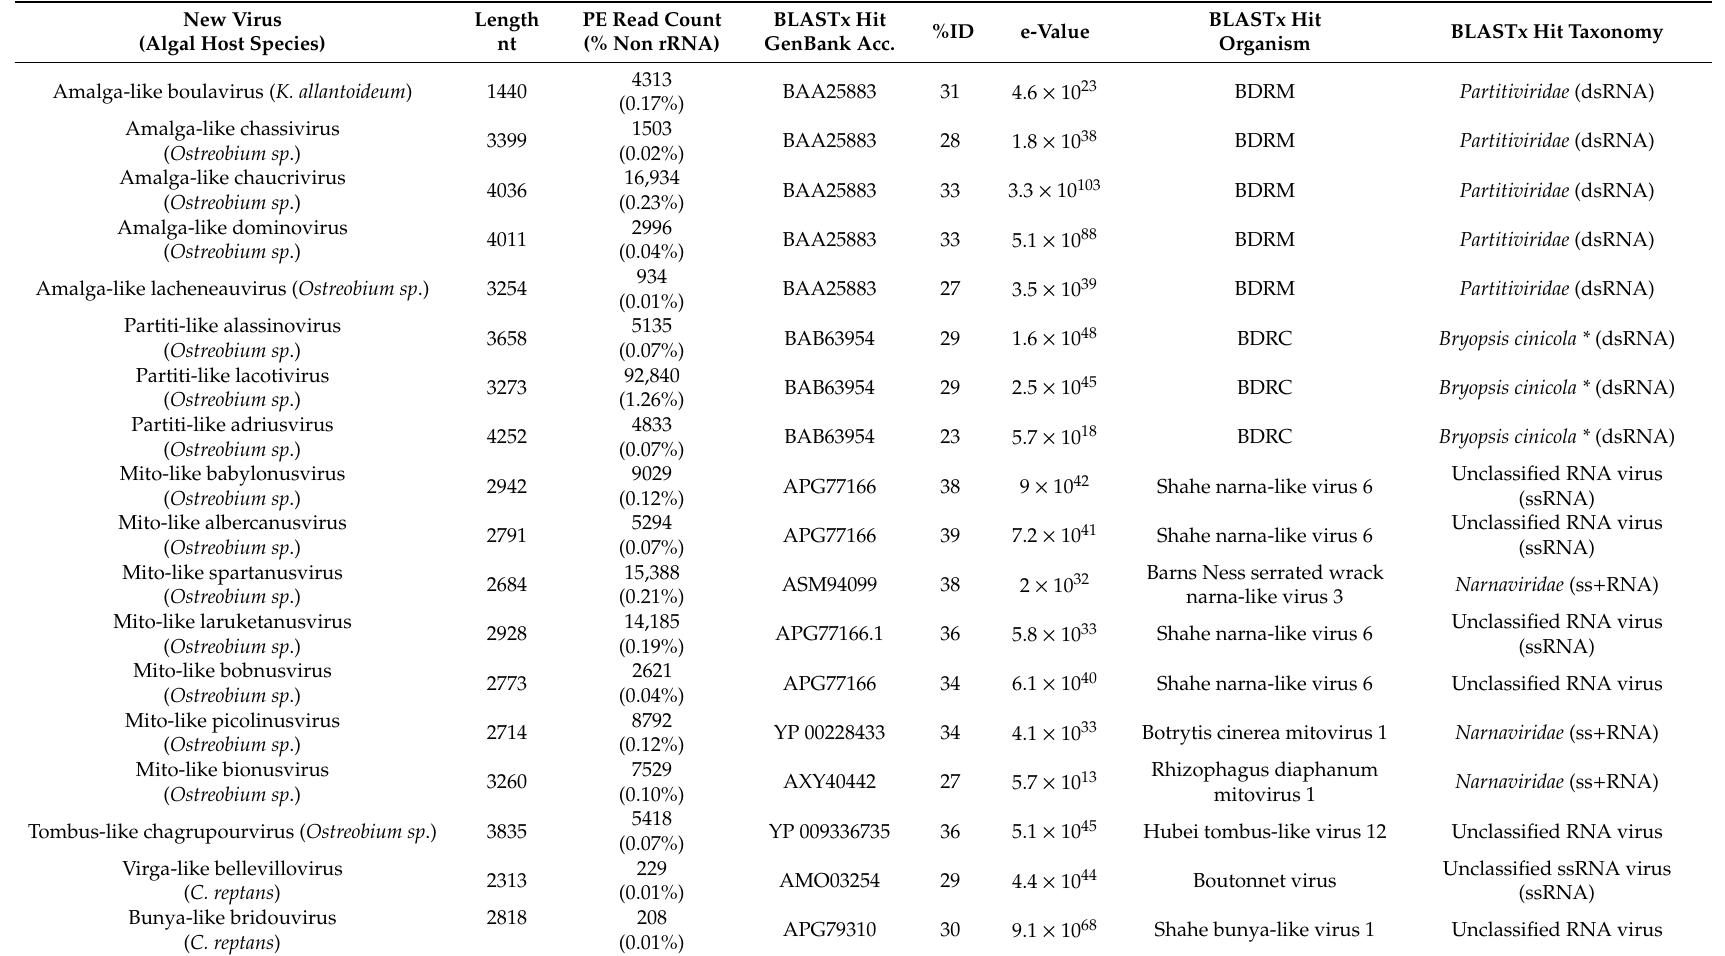
Table 2. BLASTx results of the newly described virus-like sequences against nr